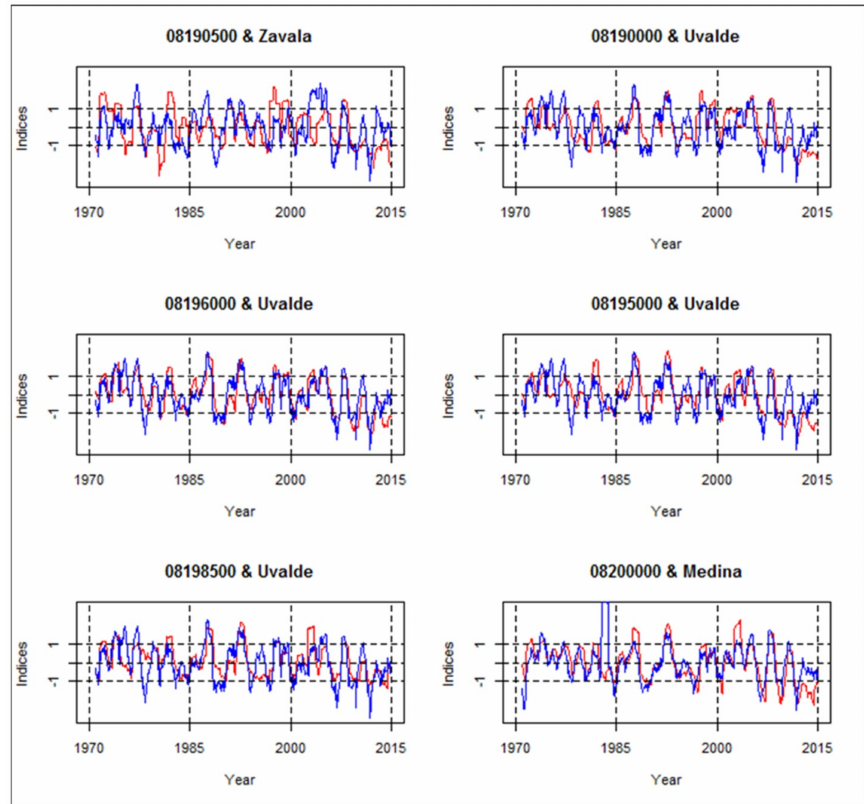
Figure 7. Streamflow Drought Index (Red) and Standardized Precipitation Index (Blue).